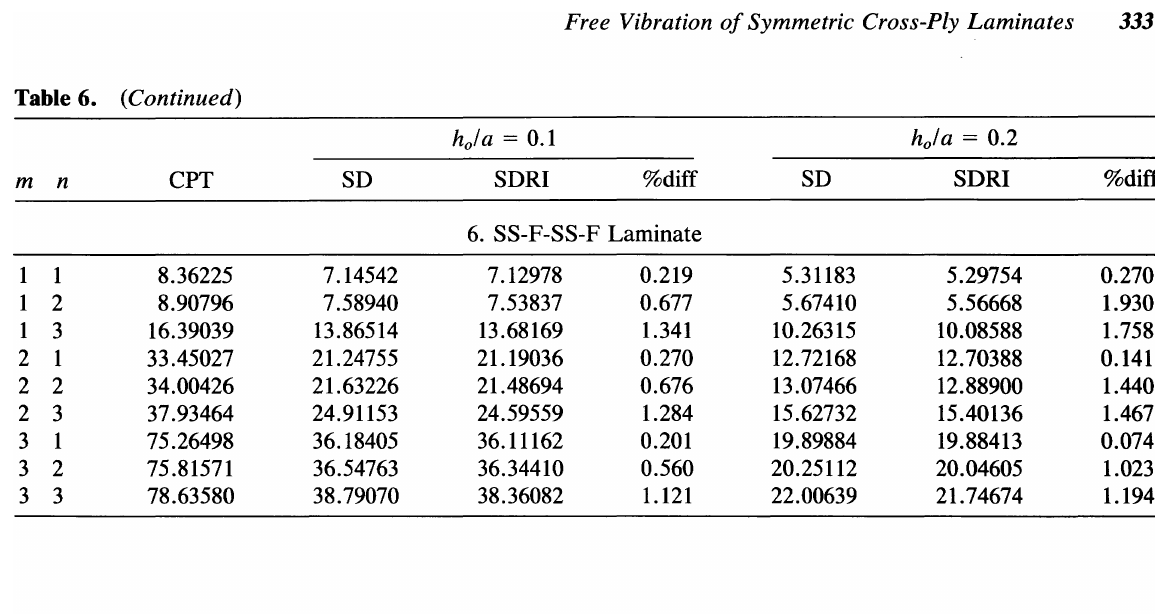
Table 7. Comparison of Classical (CPT), Shear Deformation (SD) only, and Shear Deformation with Rotatory = 1,2,3) Free Vibration Frequencies of Specially Orthotropic Square Inertia (SDRI) Solutions for Nine (m, n = Laminates (hoi a